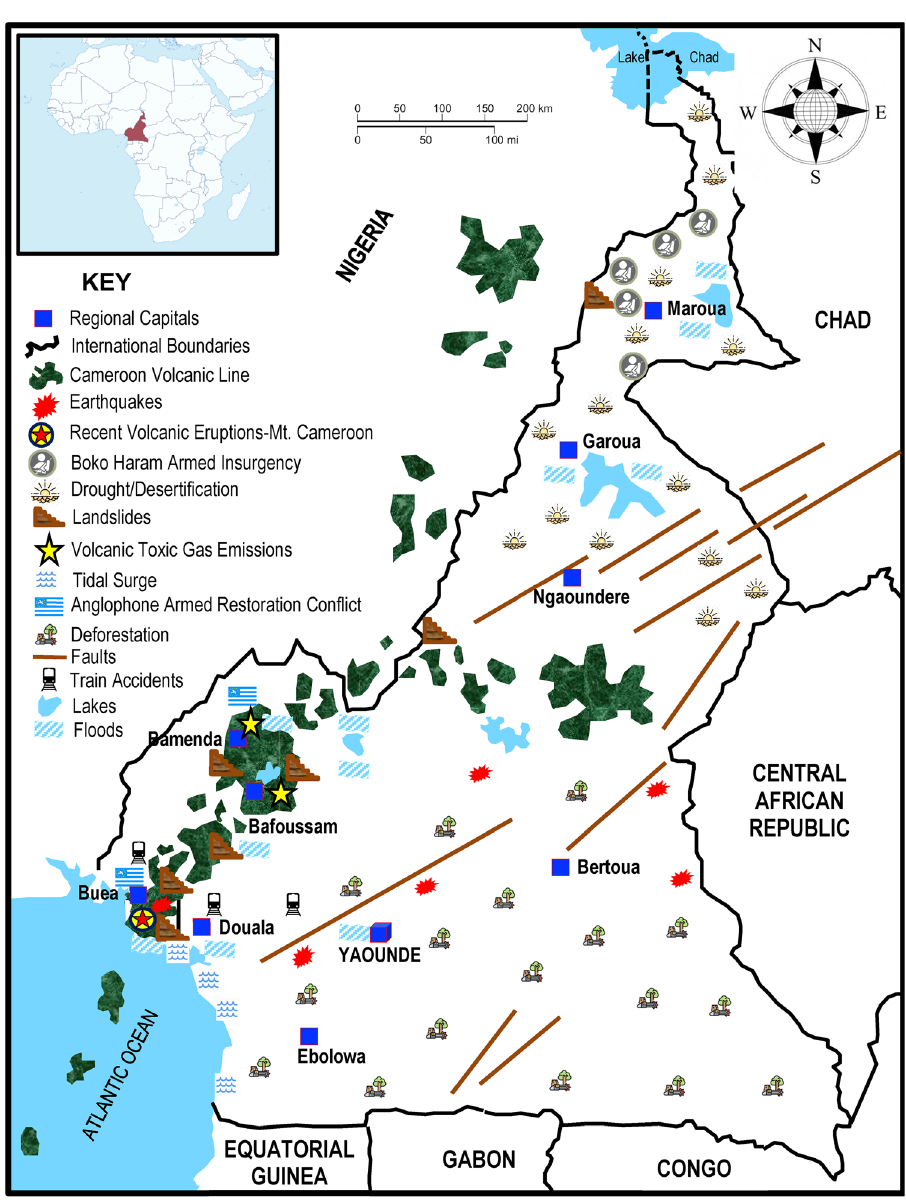
Fig. 3 Cameroon map